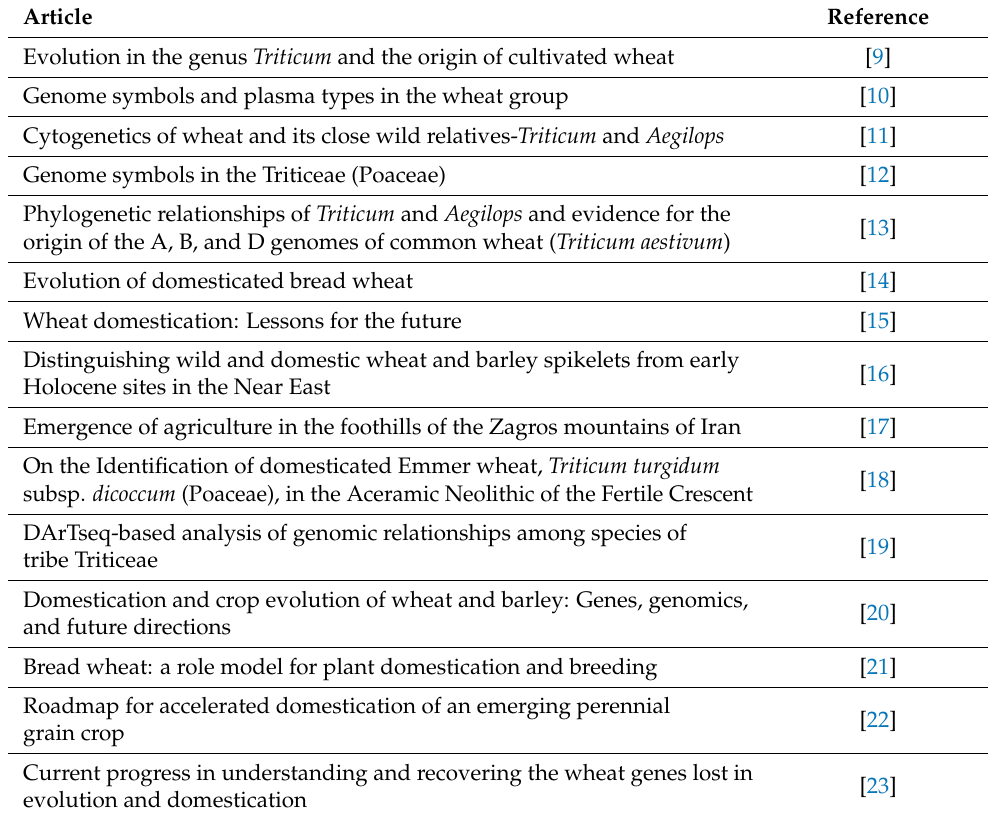
Table 1. Some key articles regarding the trend of wheat